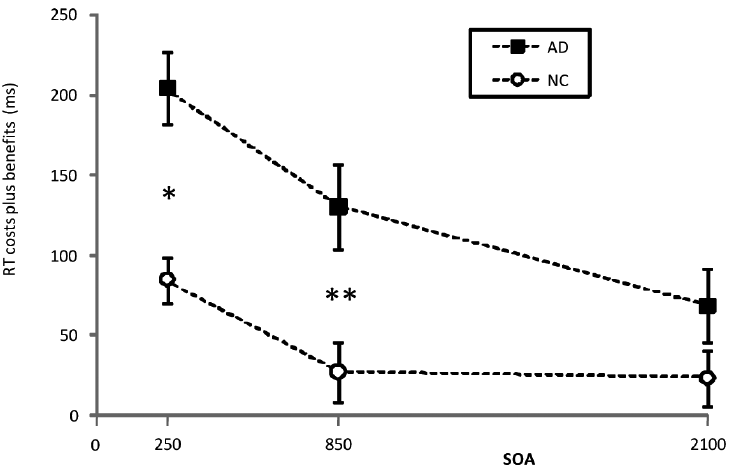
Fig. 1. Mean RT costs plus bene fi ts for each SOA (250 ms, 850 ms and 2100 ms) condition in the AD group and the NC group. Figure 1 illustrates the mean RT costs plus bene fi ts for the two SOA conditions. Data are presented as mean (SE) RTs for each group. The mean RT costs plus bene fi ts of the AD and the NC groups were 184 ms and 88 ms for the 250 ms SOA condition and 137 ms and 27 ms for the 850 ms SOA condition, and 71 ms and 23 ms for the 2100 ms SOA condition, respectively. The ANOVA with repeated measures (three times) showed that the AD group had signi fi cantly higher RT costs plus bene fi ts than the NC group ( F = 11.10, p = 0.003). Signi fi cant effects of the SOA were also found ( F = 9.69, p < 0.001). However there were no signi fi cant interactions of the group by the SOA ( F = 1.02, p = 0.37). AD = Alzheimer’s disease, NC = normal control, SOA = stimulus onset asynchrony, ms = milliseconds. The black squares were the results of the AD group while the white circles were those of the NC